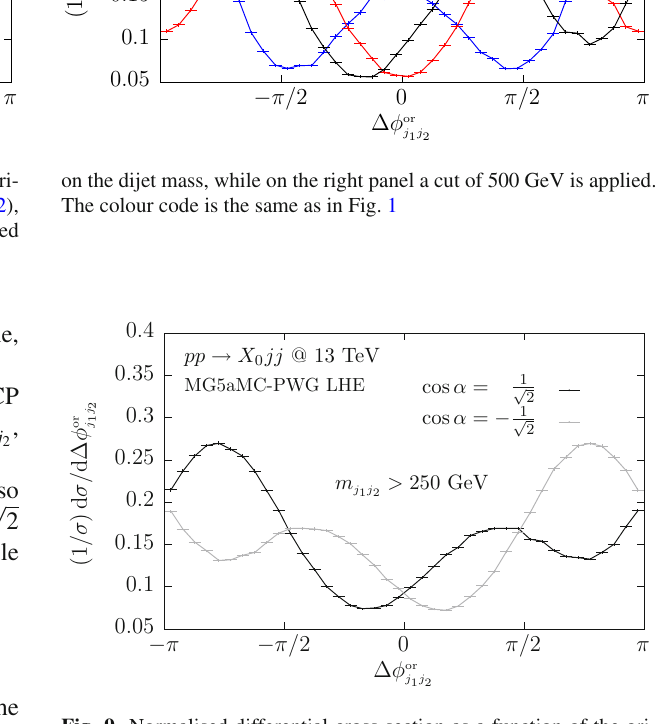
√ 2 (black curve) and